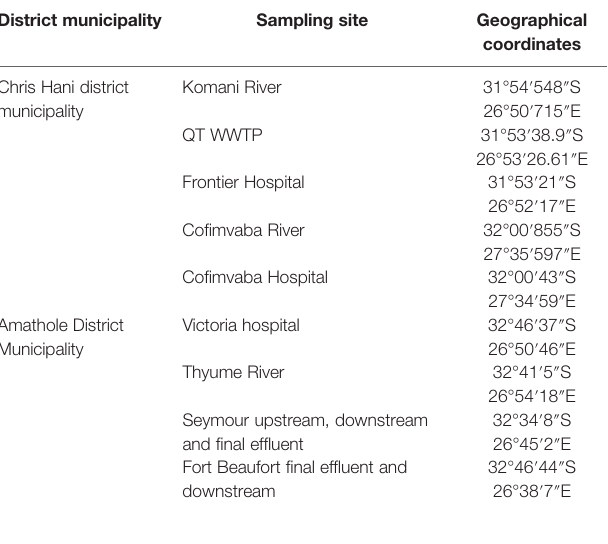
TABLE 1 | Sampling sites and their